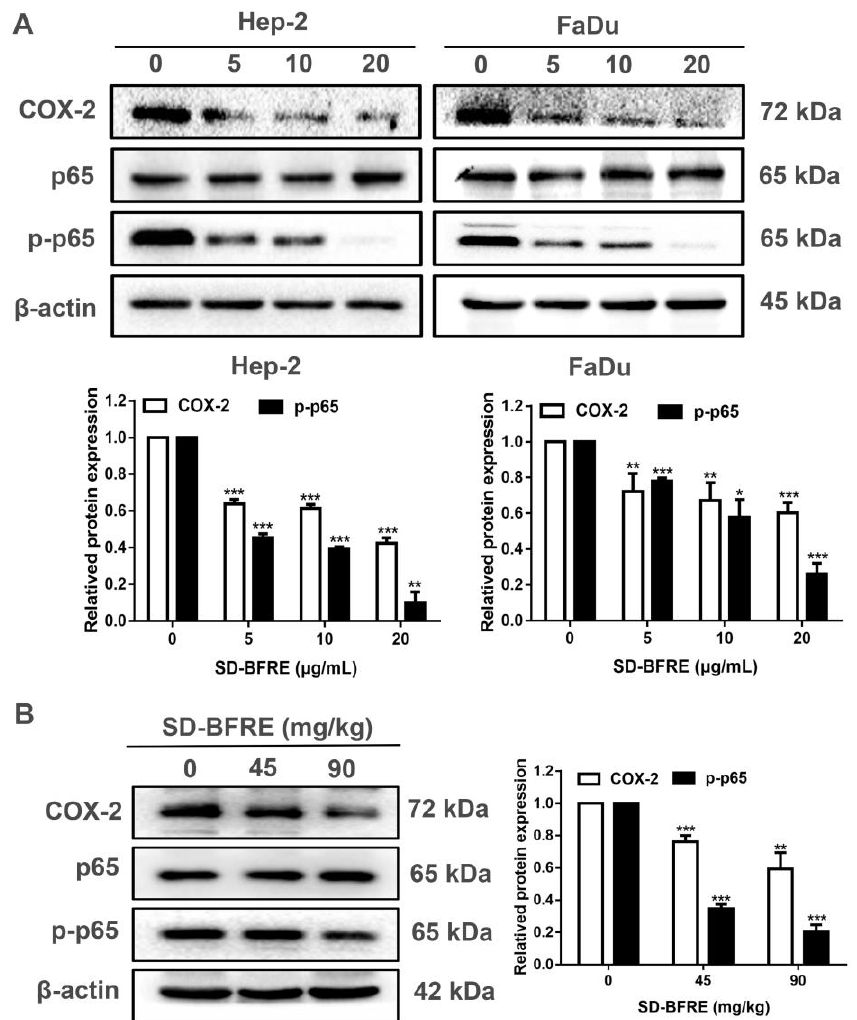
Figure 6. SD-BFRE inhibits NF- κ B p65 and COX-2 signaling in vitro and in vivo. ( A ) After being incubated with SD-BFRE for 24 h, the relative expressions of COX-2, NF- κ B p65 and p-NF- κ B p65 were quantified by Western blot assay. ( B ) Tumor tissue proteins were extracted and prepared, and the relative protein levels of COX-2, NF- κ B p65 and p-NF- κ B p65 were quantified by Western blot. β -actin was served as an internal reference (* p < 0.05, ** p < 0.01 or *** p < 0.001, compared to 0 µ g/mL or 0